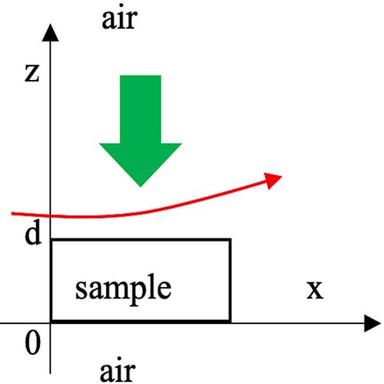
Schematic representation of the sample orientation with respect to the propagation of pump and probe beams.